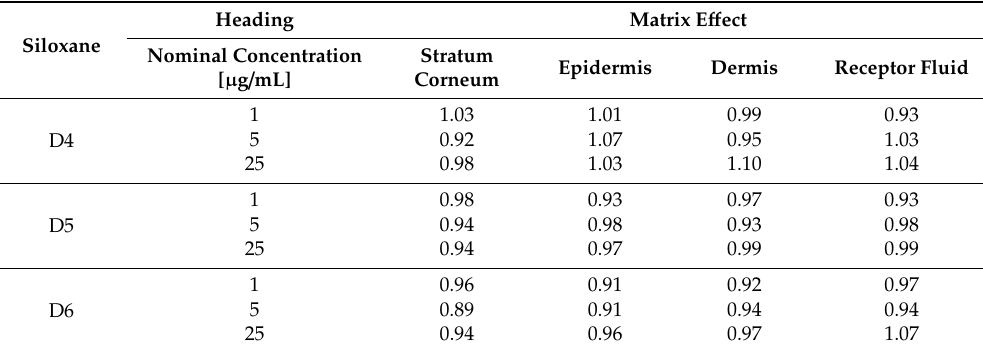
Table 3. Matrix e ff ect coe ffi cient for D4, D5, and